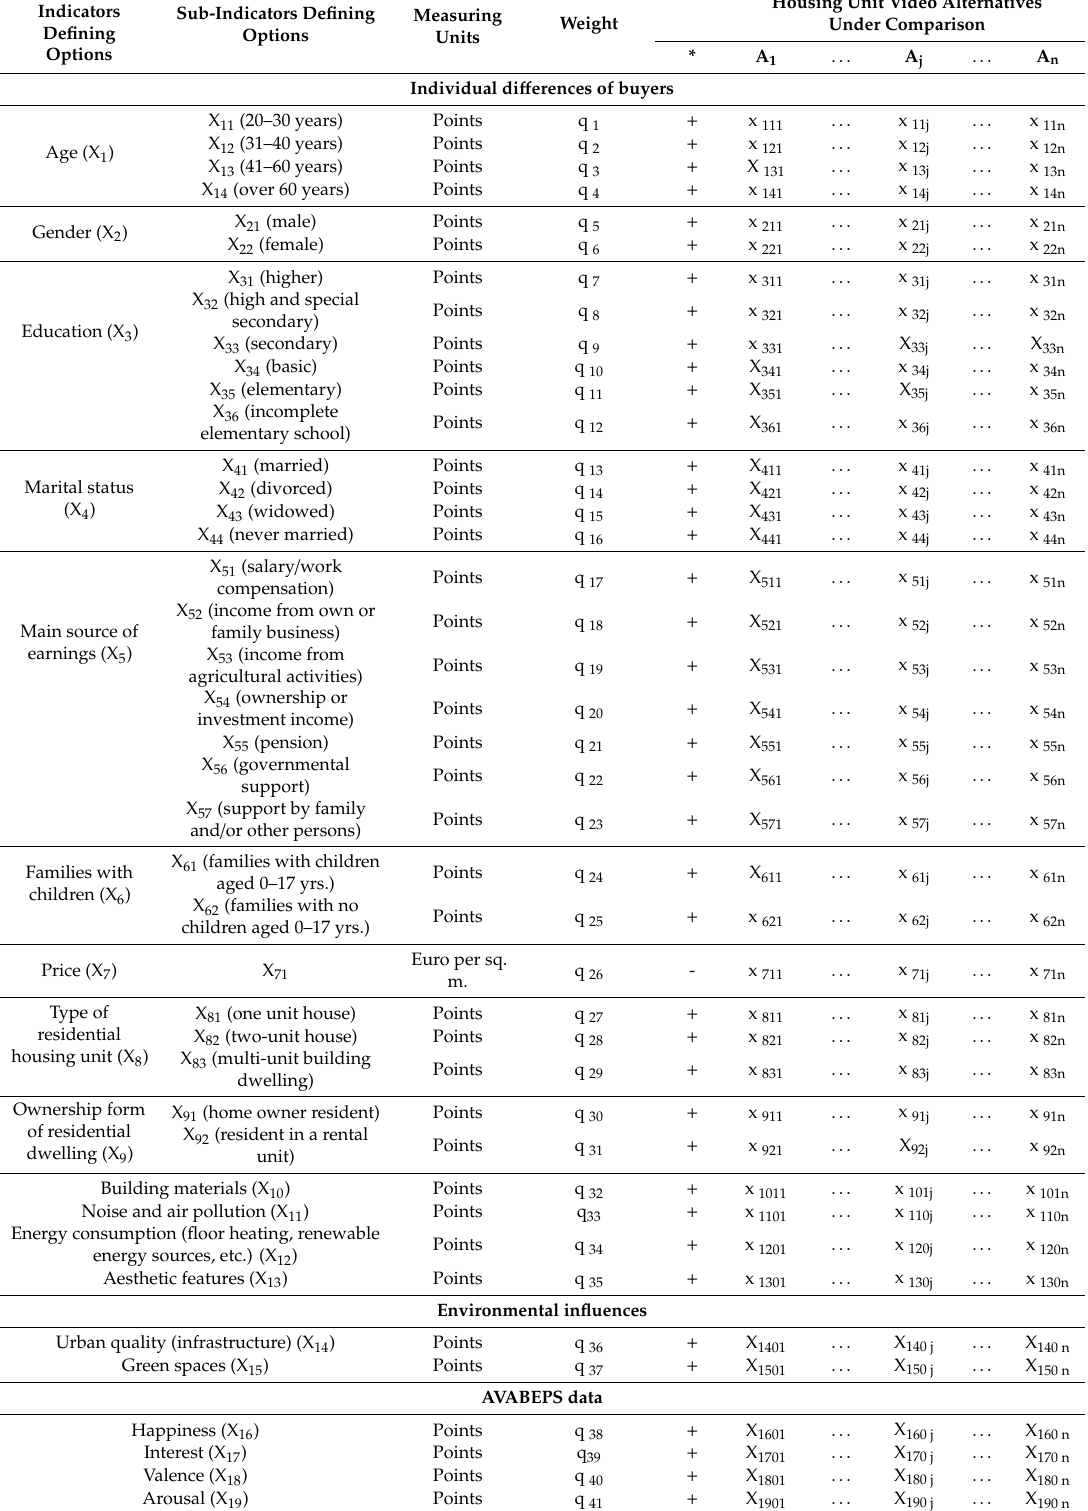
Table 6. Sum segmentation, neuro housing decision-making